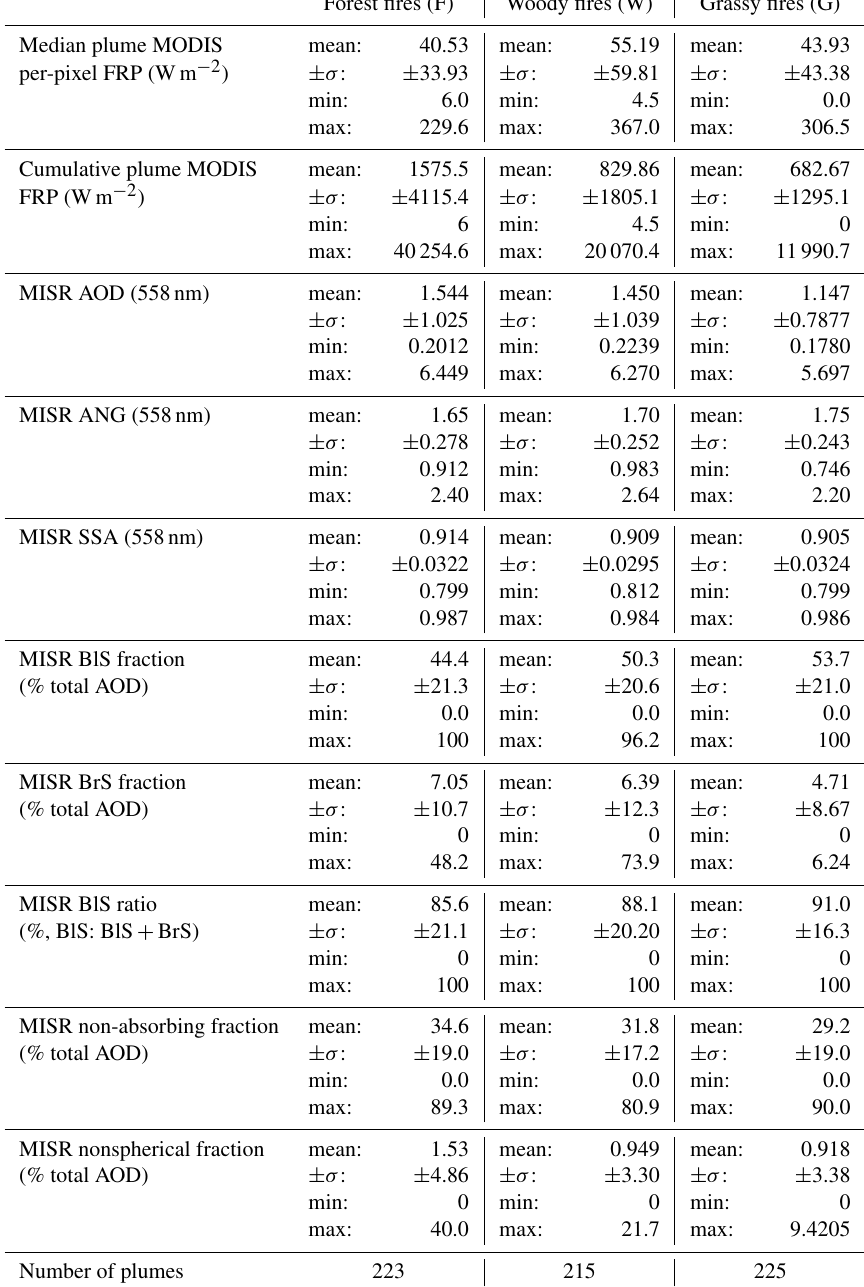
Table 4. Statistical summary of the main smoke plume parameters for each fire category. The following abbreviations are used in the table: FRP – fire radiative power, AOD – aerosol optical depth, ANG – Ångström exponent, SSA – single-scattering albedo, BlS – black smoke, and BrS – brown